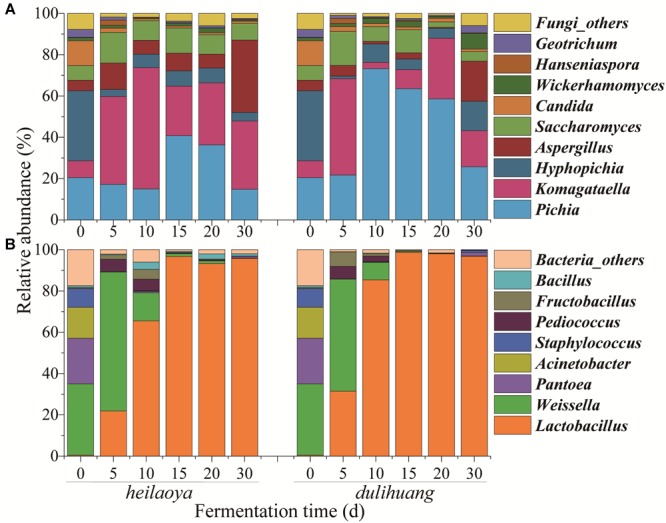
Distribution of microbiota during the fermentation process in two cultivars of hulless barley fermented grains (heilaoya and dulihuang). Temporal profile for the relative abundance of fungal taxa (A) and bacterial taxa (B) represents at the genus level. “Others” represents the genera with relative abundance <1%.